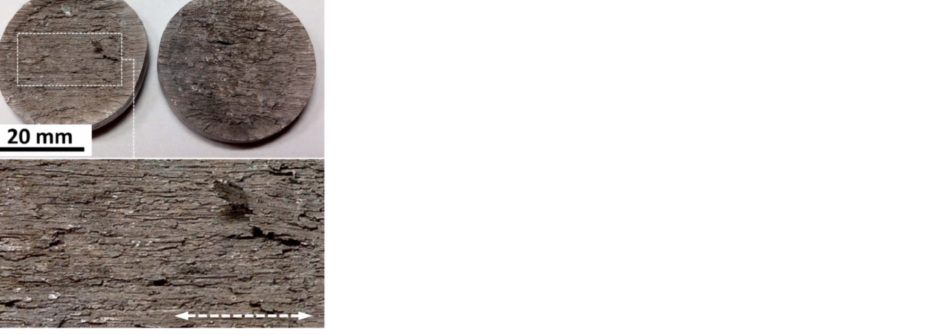
Figure 7. Optical micrograph of the recovered sample shock compressed to approximately 1.7 GPa [40].